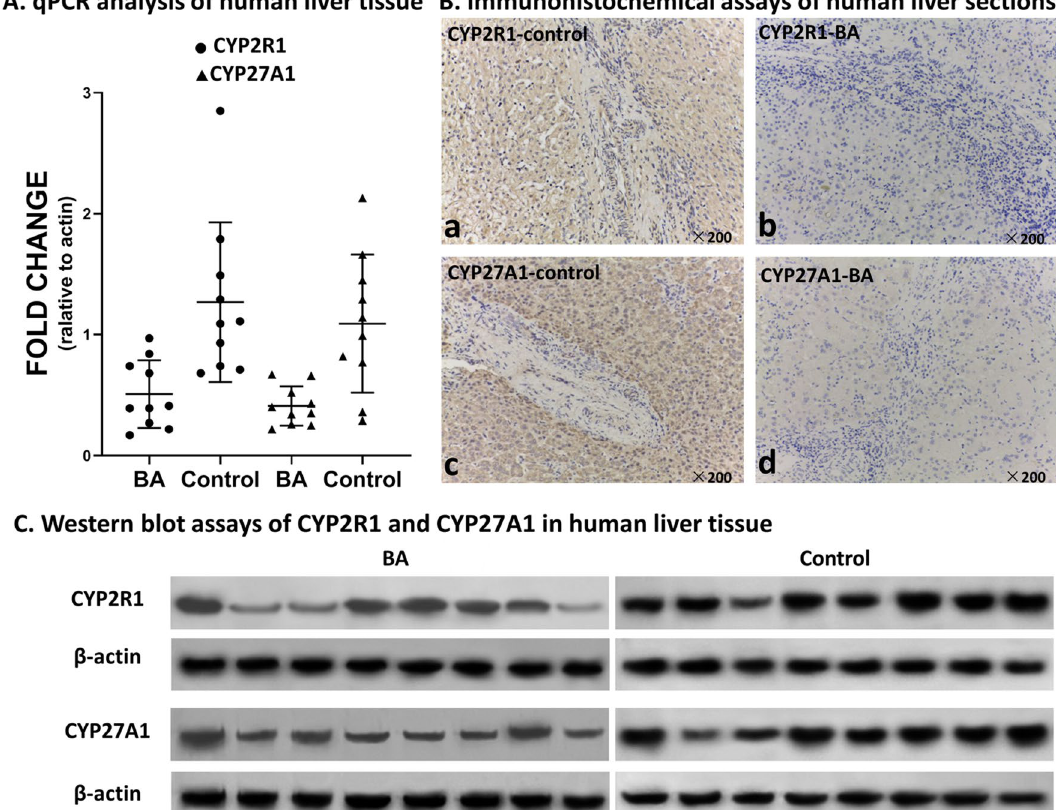
Figure 2. Expression of 25-hydroxylase CYP2R1 and CYP27A1 in liver tissue of BA and control groups. ( A ) Dot plot of mRNA levels of CYP2R1 and CYP27A1. ( B ) The expression of CYP2R1 and CYP27A1 in the BA and control groups detected by immunohistochemistry. Brown staining represents expression of CYP2R1 and CYP27A1. a and b show expression of CYP2R1 in the control and BA groups, and c and d show expression of CYP2R1 in the control and BA groups, respectively. ( C ) The expression of CYP2R1 and CYP27A1 in the BA and control groups detected by western dopods or typical HSC morphology (Fig. 3). On the seventh day of culture, the lipid droplets in the cytoplasm disappeared completely, and the cells became spindle-shaped. After 12–14 days of culture, the cells grew into monolayers. Immunofluorescence assays showed that the percentage of α-SMA-positive cells was 97% on day 7 of culture (Fig. 3). Calcitriol inhibits expression of fibrosis-related genes, proliferation and migration of primary HSCs from patients with BA in vitro. Primary HSCs of patients with BA were cultured in vitro with calcitriol at 100, 200 and 400 nM for 24 h. qPCR indicated that expression of TGF-β1, Col-1α1 and α-SMA was decreased after addition of calcitriol, and the decrease was most significant with 200 nM calcitriol (Table 2). The proliferation of primary HSCs treated with 200 nM calcitriol for 24, 48 and 72 h was lower than that of untreated HSCs (0.34 ± 0.13 vs. 0.46 ± 0.09, P < 0.01; 0.88 ± 0.15 vs. 1.01 ± 0.11, P < 0.01; 1.51 ± 0.13 vs. 1.73 ± 0.10, P < 0.01). The Transwell assay showed that the migrated cell count of the untreated group was 382 ± 51, and that of the 200 nM calcitriol group was 223 ± 76, which was a significant difference ( P < 0.01) (Fig. 4). These results suggest that calcitriol can inhibit the proliferation and migration of HSCs. Construction of CYP2R1 lentivirus and validation of hepatocyte transfection effect. CYP2R1- overexpression lentivirus (CL1674-PDS237_PL-CMV-GFP-CYP2R1) and CYP2R1-interference lentivirus (CL1676-PDS126_PL6.3-shRNA-GFP-CYP2R1-932) vectors were constructed with titers of 4.5 × 10 8 TU/mL. QSG-7701 hepatocytes were transfected with CYP2R1-overexpression lentivirus, CYP2R1-interference lentivi- rus or negative control lentivirus. qPCR showed that the expression of CYP2R1 mRNA in the CYP2R1 overex- pression group was significantly higher than in the negative control group (9.39 ± 0.34 vs. 1.0 ± 0.04, P < 0.001), and expression in the CYP2R1-interference group was significantly lower than in the negative control group (0.37 ± 0.06 vs. 1.0 ± 0.04, P < 0.001). These results indicated that CYP2R1-overexpression lentivirus increased expression of CYP2R1, while CYP2R1-interference lentivirus reduced expression of CYP2R1.